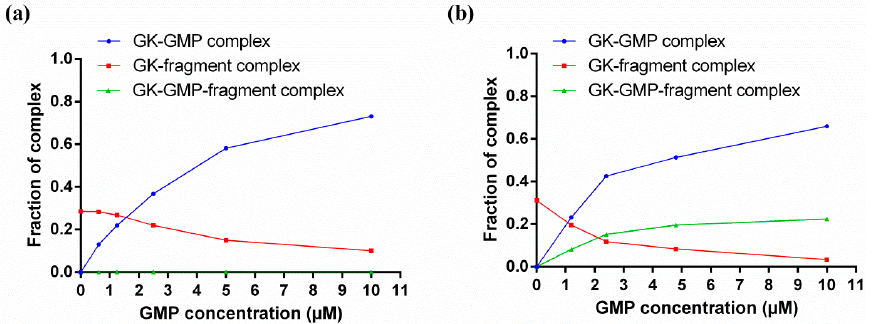
Figure 4. Native MS competitive binding experiments between Pv GK natural substrate 5 ′ -guanosine monophosphate (GMP) and a fragment hit, illustrating a situation where ( a ) GMP is competing with the fragment for the same protein-binding site; ( b ) GMP is not competing with the fragment and is binding to a different protein site.